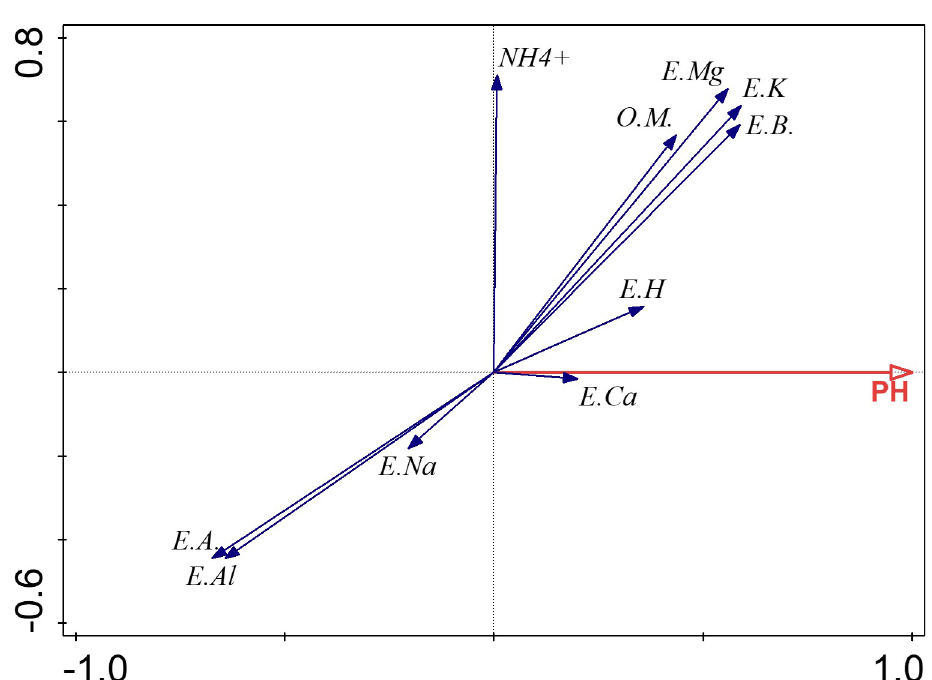
Fig 4. Correlations of exchangeable cations and organic matter to the soil pH. Various soil characteristics are used as independent variables to assess their contribution to the dependent variable, soil pH, in this redundancy analysis. E. Al = exchangeable Al 3+ , E.H = exchangeable H + , E.A = exchangeable acidity (E.Al + E.H), E.K = exchangeable K + , E. Na = exchangeable Na + , E.Ca = exchangeable Ca 2+ , E.Mg = exchangeable Mg 2+ , E.B = exchangeable bases (E.K + E.Na + E.Ca + E.Mg), O.M = organic matter of